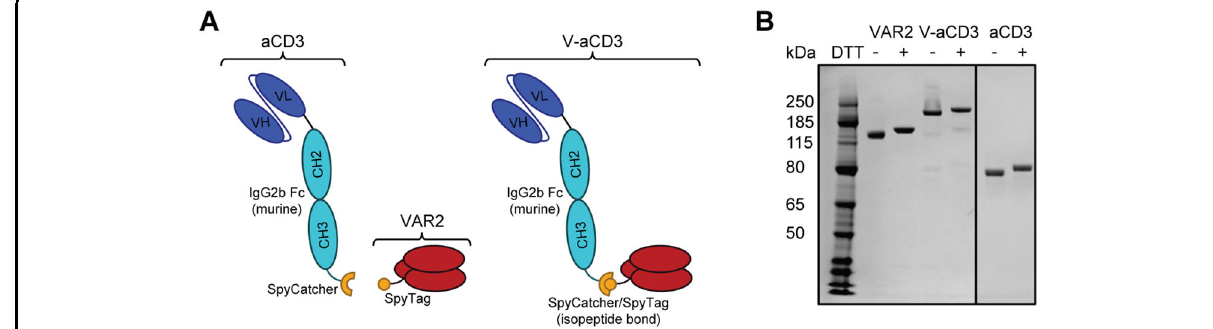
Fig. 1 Design and purity of V-aCD3. A Schematic fi gure of the construction and assembly of V-aCD3. A single-chain anti-CD3 antibody (scFv (OKT3)-Fc (murine IgG2b)) was produced with a SpyCatcher domain, which spontaneously forms a covalent bond with SpyTagged VAR2. B SDS-PAGE showing recombinant rVAR2 (lane 2 nonreduced, lane 3 reduced), V-aCD3 (lane 4 nonreduced, lane 5 denatured), and anti-CD3 (lane 6 nonreduced, lane 7